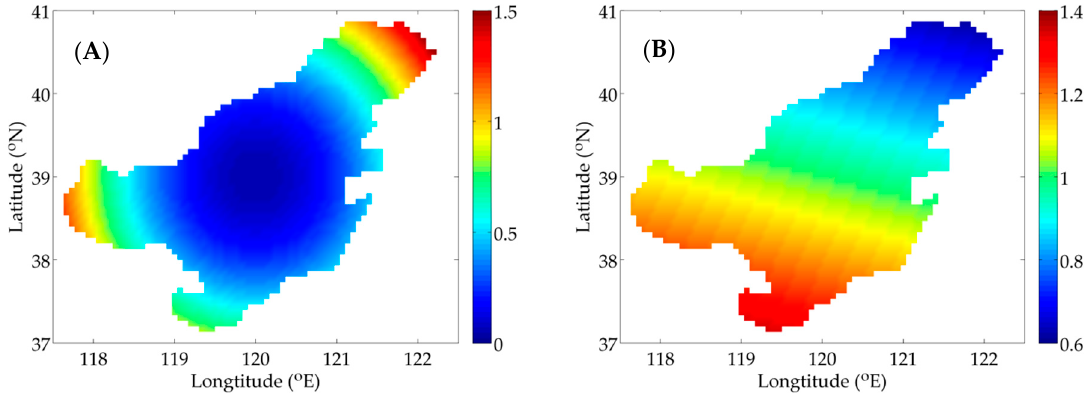
Figure 2. Given distributions of P in the idealized twin experiment 1 (IE1) ( A ); and the idealized twin experiment 2 (IE2) ( B ) (unit: mmol N m − 3 ).